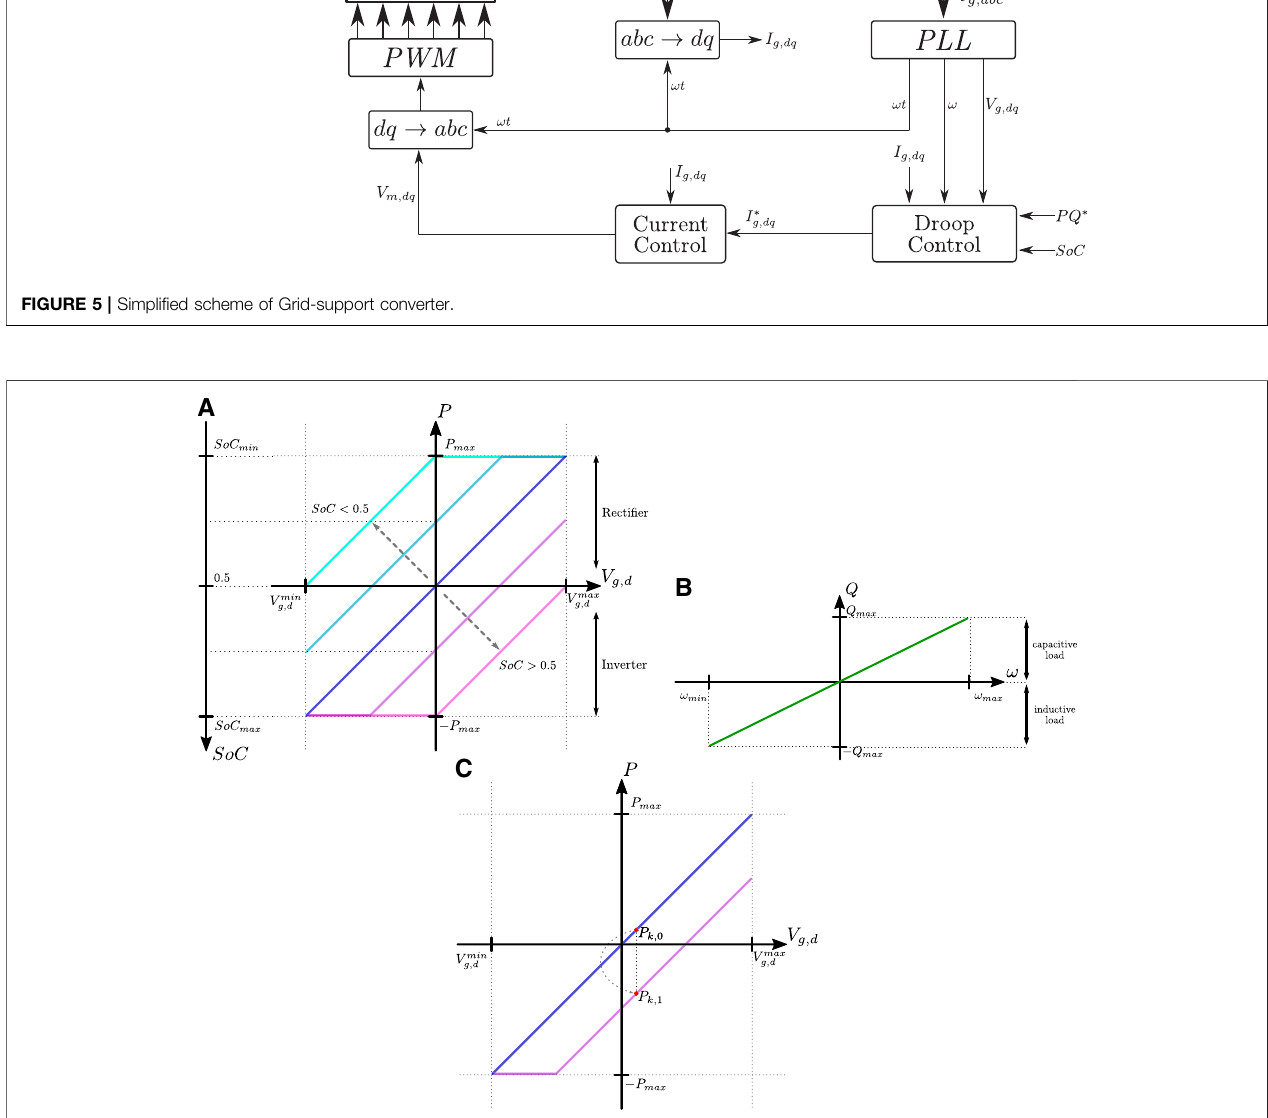
FIGURE 6 | Representation of the grid-support converter droop curves. (A) is the V − P / SoC droop, (B) the ω − Q droop and (C) example of an external power reference impact on the droop curve.